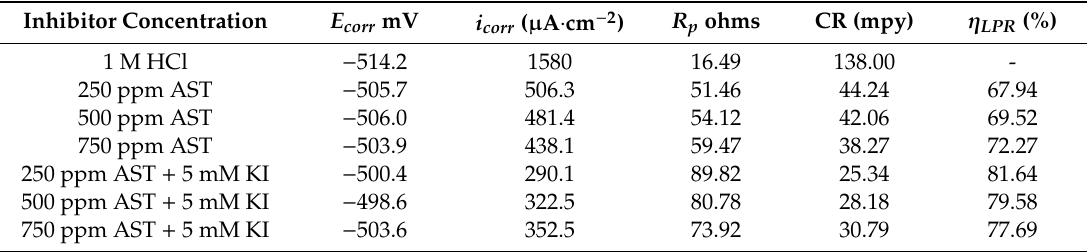
Table 1. Electrochemical kinetic parameters obtained from LPR measurements for C1018 carbon steel in 1 M HCl (blank) and with various concentrations of AST and AST + KI at 25 ◦ C. Inhibitor Concentration E corr mV i corr ( µ A · cm − 2 ) R p ohms CR (mpy) η LPR (%) 1 M HCl − 514.2